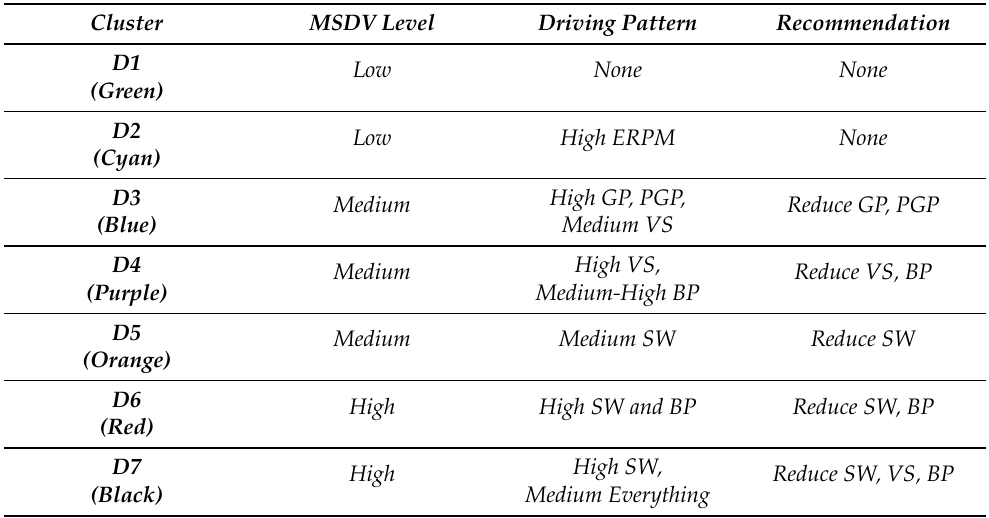
Table 8. Motion sickness level of each cluster, the characteristic that causes discomfort in passengers and the recommendations given to reduce